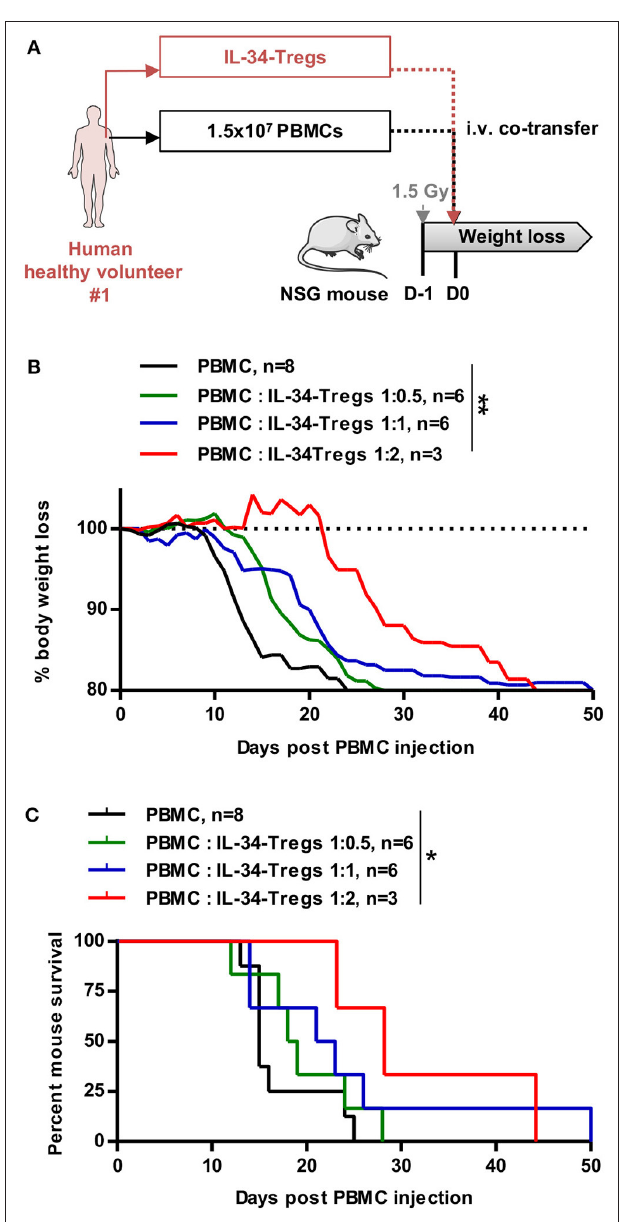
FIGURE 6 | Cell therapy with IL-34-expanded CD8 + Tregs delays aGVHD. (A) Schematic depicting treatment of mice in the model of xenogeneic GVHD. PBMCs injected are syngeneic to the expanded Tregs co-injected. (B) Mouse body weight follow-up and (C) mouse survival after PBMC injection (D0) with or without Tregs expanded in the presence of IL-34-differentiated macrophages in a range of PBMC:Tregs ratio. n = 3–8. (B) Two-way RM ANOVA, ** p < 0.01. (C) Log Rank (Mantel Cox) test. * p <